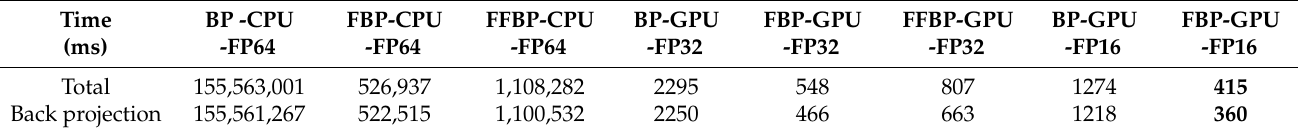
Table 7. Running time of the eight